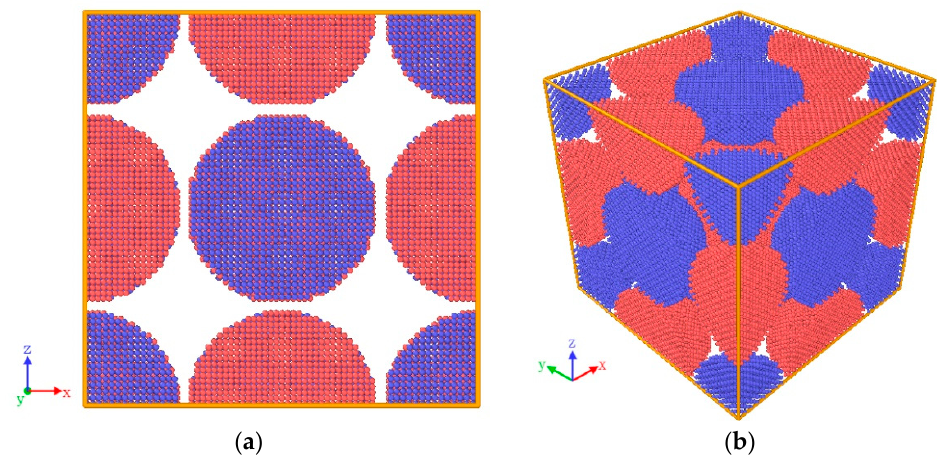
Figure 3. The model of the initial unit (Fe atoms are colored in red and Al atoms are colored in blue) ( a ) Front view ( b ) Oblique view.